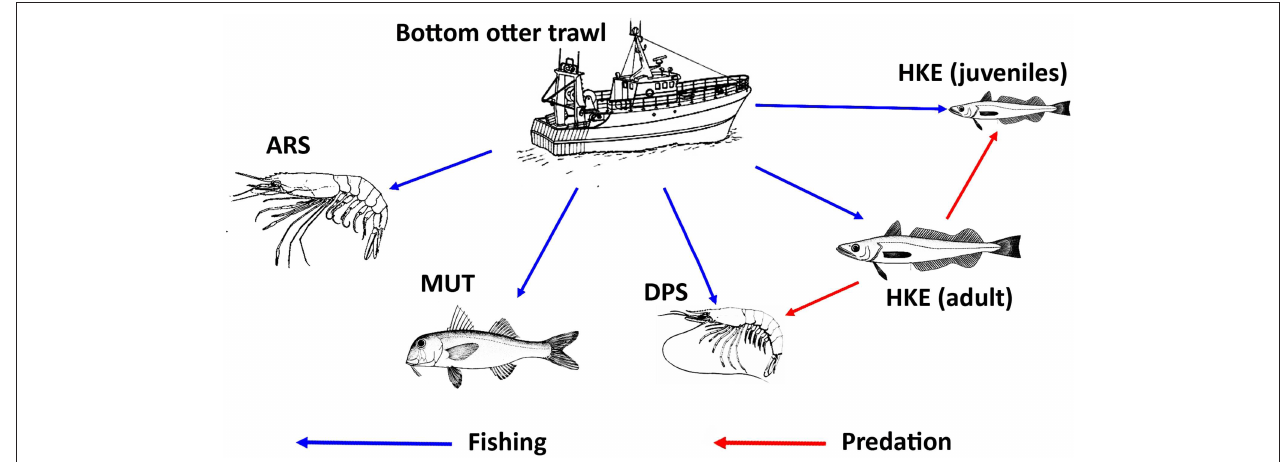
FIGURE 4 | Representation of the relationships between trawl fishing and the main stocks exploited in the Strait of Sicily, together with the main trophic relationships between stocks. Adult HKE is a predator of DPS and HKE juveniles. MUT and ARS were considered as stand-alone stocks with no trophic relationship with other investigated species. The source of the image for ARS is Fischer et al. (1987). The source of the images for DPS, HKE, and MUT is FAO (2017). All these images were reproduced with permission of FAO Copyrigh